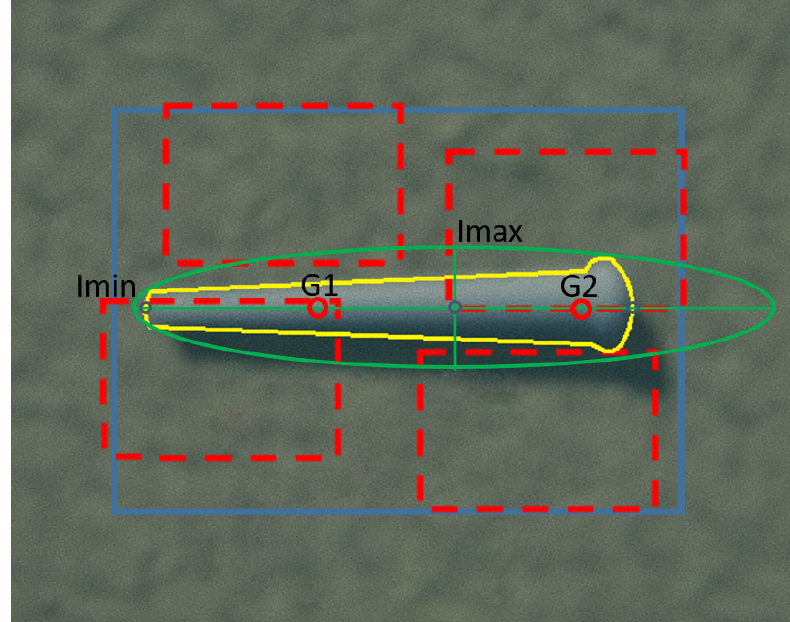
Figure 23. Vision phase 3: preliminary calculation of stable grasping points for multi-robot intervention in pipes considering the minimum and maximum inertia axis of the